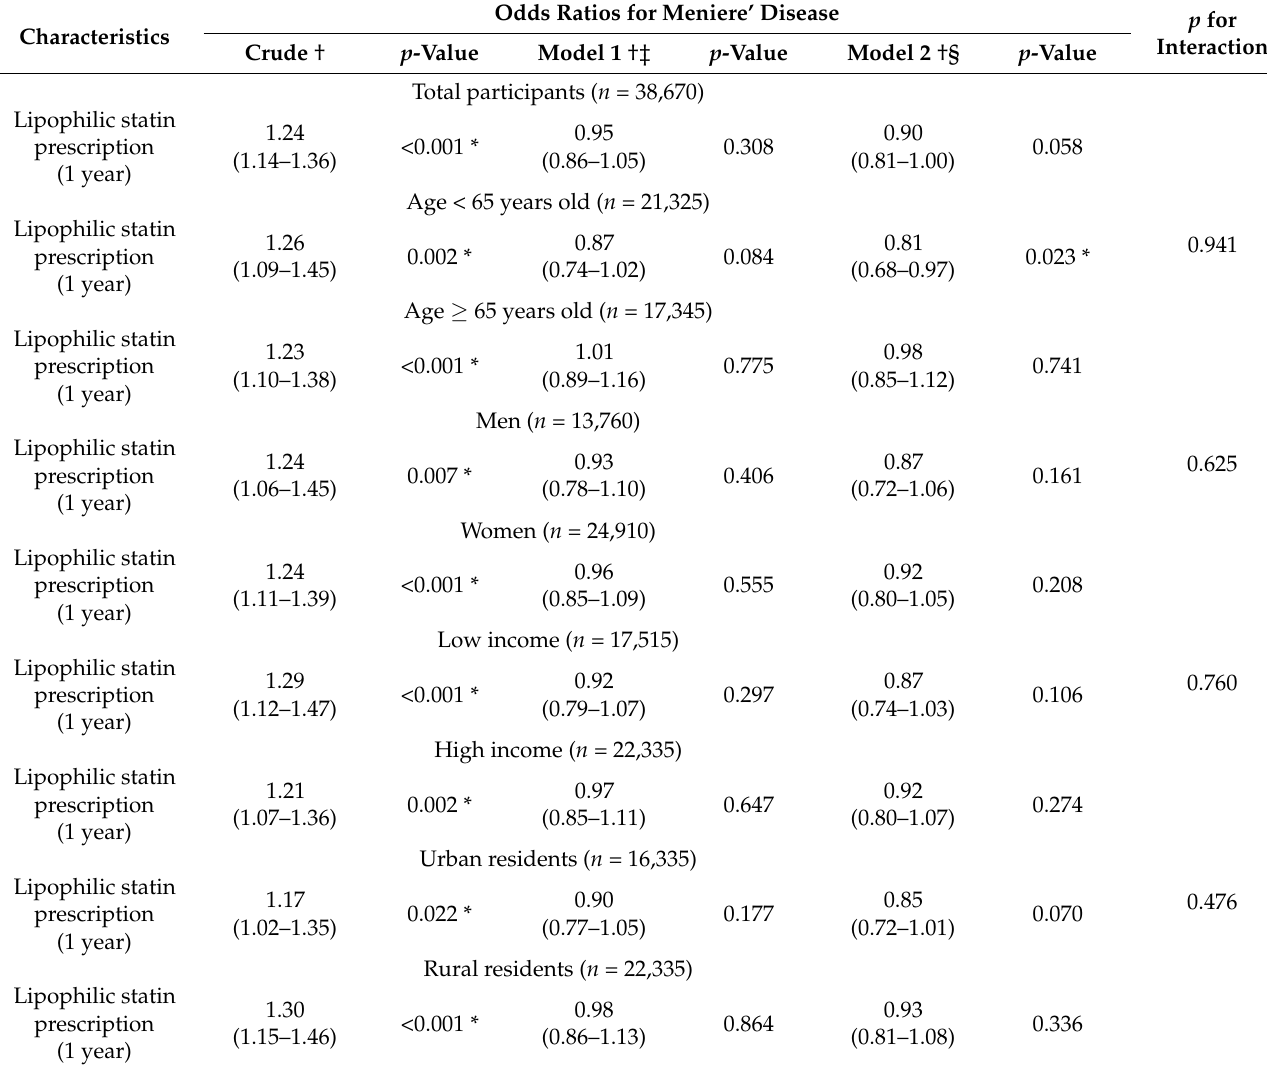
Table 3. Crude and adjusted odd ratios (95% confidence interval) of date of lipophilic statin prescription (1 year) for Meniere’s disease with stratified subgroup according to age, sex, income, and region of residence.